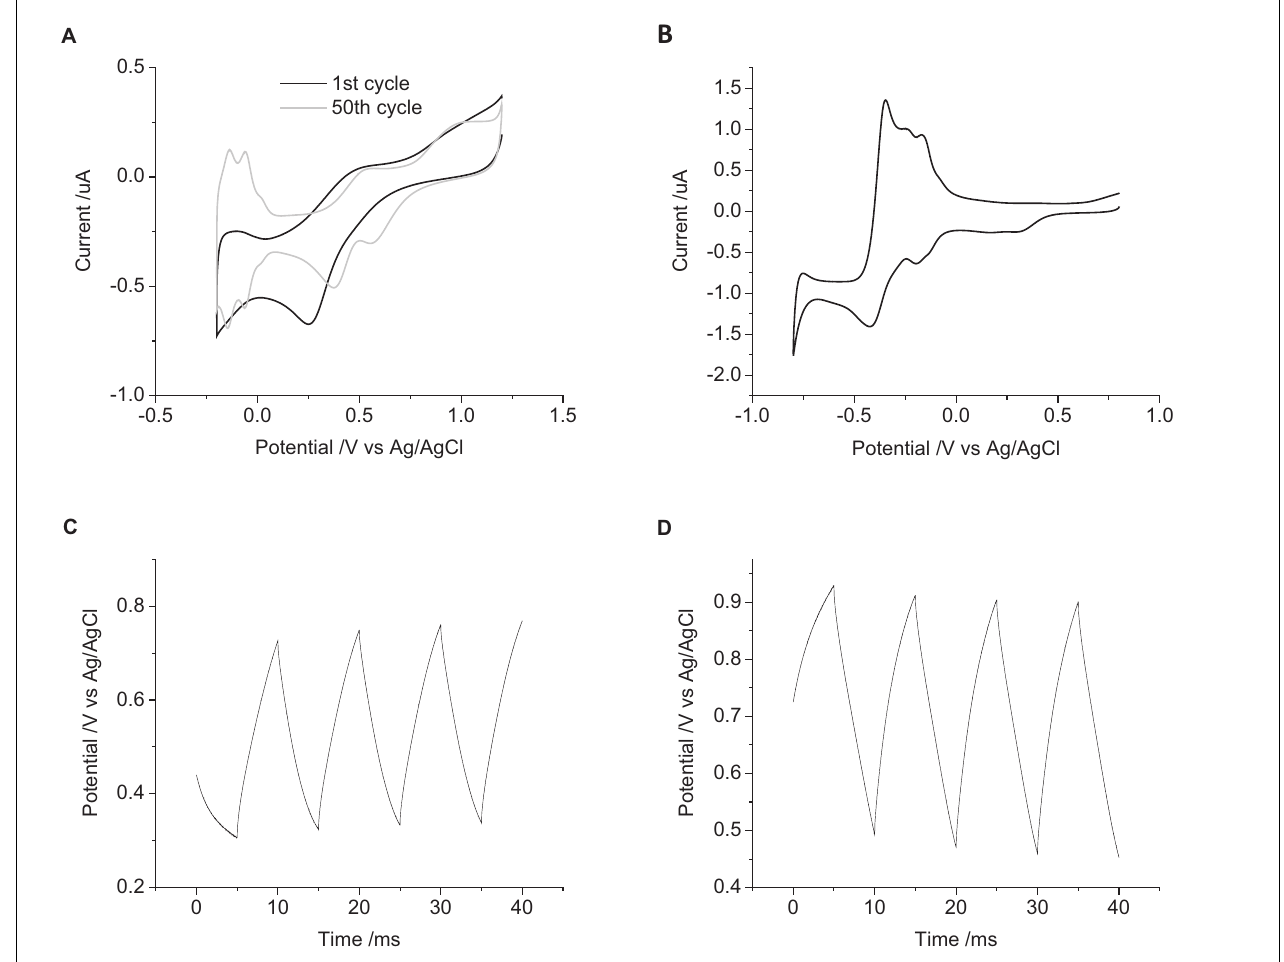
FIGURE 7 | (A) First (black) and fiftieth (gray) cycle of a mechanically polished 0.6 mm diameter platinum electrode in 0.5 M H 2 SO 4 at 50 mV s − 1 . (B) First cycle of an acid polished 0.6 mm diameter platinum electrode in degassed 0.1 M NaCl at 100 mV s − 1 . Multiple pulse chronopotentiometry of an acid polished 0.6 mm diameter platinum electrode in degassed 0.1 M NaCl. (C) Cathodic, (D) anodic pulse first with a current density of 10 µ C cm − 2